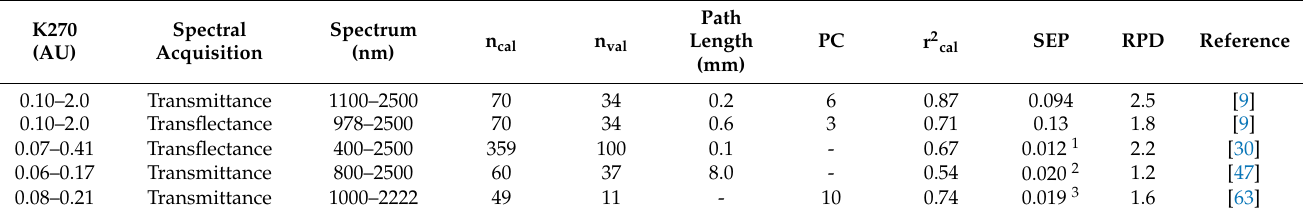
Table 6. PLS statistics obtained for K270 of olive oils using different K270 ranges, visible/NIR spectral intervals and optical path